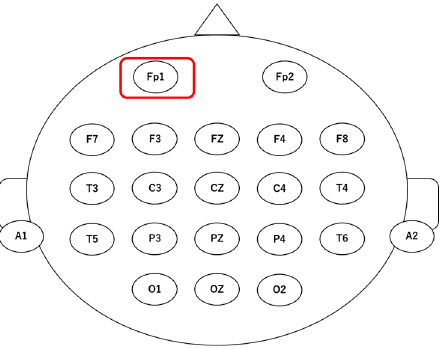
Figure 3. Measurement points of the international 10–20 system.